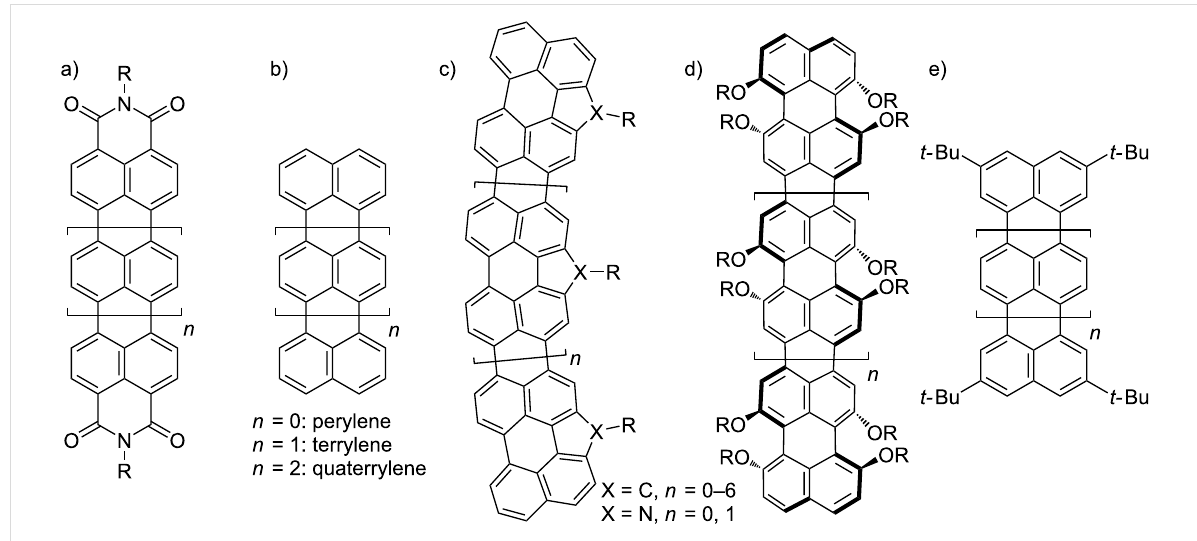
Figure 1: Chemical structures of a) oligorylene-bisimides, b) oligorylenes, c) bay-bridging oligorylenes, d) bay-alkoxy oligorylenes, and e) tetra- tert - butyl oligorylenes.